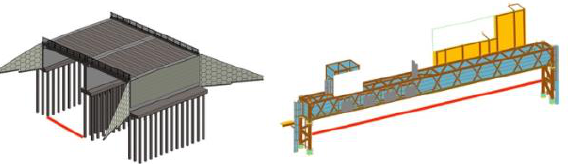
Figure 2: "BridgeSpan" and "GantrySpan" definition in red line